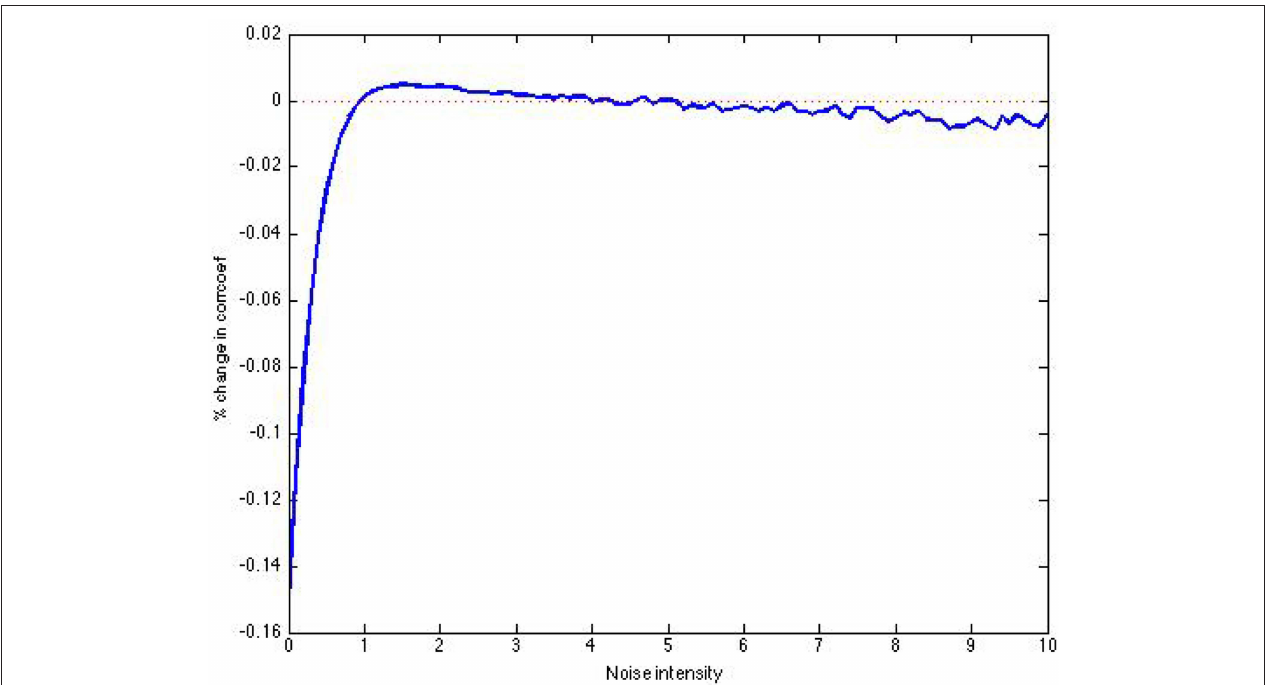
FIGURE 15 | Post-SSR increase in correlation coefficient using 10,000 threshold units, over 3000 time units.